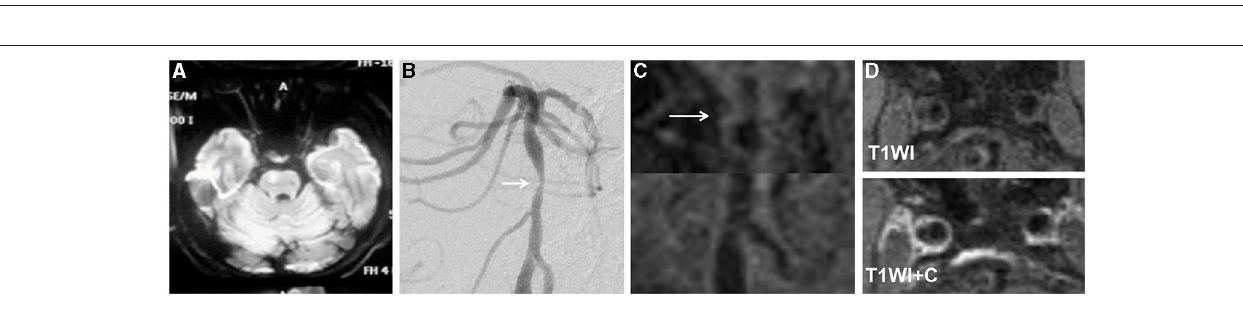
FIGURE 3 | A 68-year-old man presented with dysarthria for 20 days. The DWI showed an infarct located at the right pons (A) . The DSA showed severe stenosis in the middle segment of the basilar artery (arrow) (B) . The HRMRI demonstrated a diffuse distributive plaque (arrow) (C) . There was no plaque enhancement